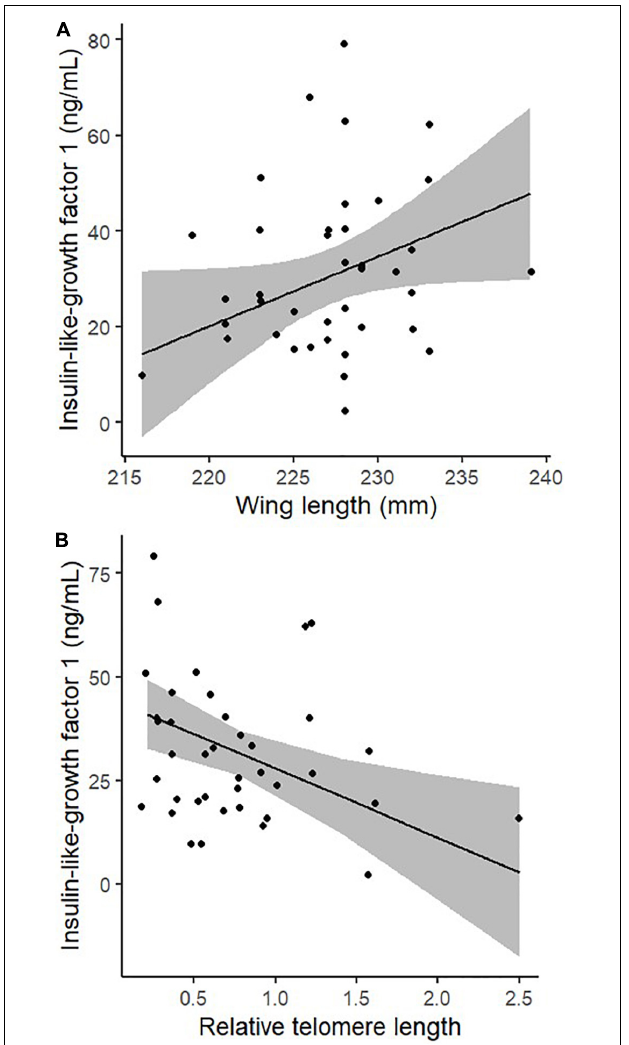
FIGURE 1 | Panel (A) shows the relationship between wing length and plasma levels of insulin-like growth factor 1, in adult Alpine swifts. Panel (B) presents the association of relative telomere length and plasma levels of insulin-like growth factor 1, in adult Alpine